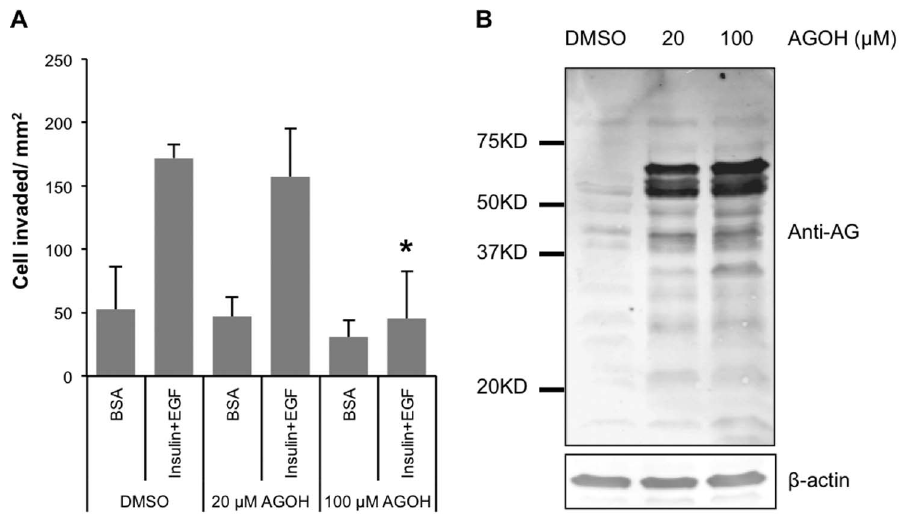
Figure 2. AGOH inhibits MDA-MB-231 cells invasion. (A) MDA-MB-231 cells were treated with AGOH at the indicated concentration and then assessed for Matrigel invasion toward the combination of 5 ng/ml EGF and 250 ng/ml insulin. (B) Cells treated with AGOH for 3 days were harvested in RIPA buffer, immunoblotted with polyAG-antibody. Asterisk (*) symbolizes a p value , 0.05. These results are representative from at least three separate experiments.